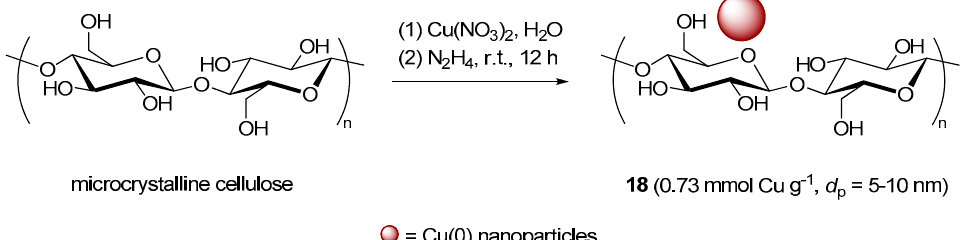
Scheme 10. Preparation of Cu nanoparticles on cellulose, 18 .